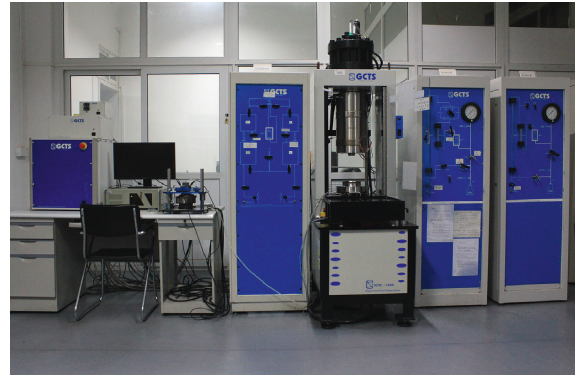
Figure 5: Picture of the experimental apparatus.